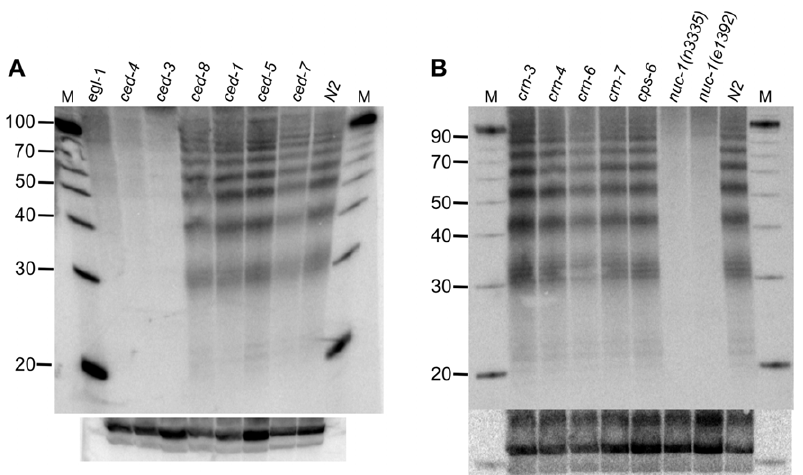
Figure 2. Analysis of small DNA pieces in C.elegans apoptosis mutant strains. Northern analyses as in Figure 1 were performed on ‘‘total RNA’’ isolated from C. elegans embryos of wildtype (N2) animals or those containing mutations in genes that affect the killing or engulfment phase of apoptosis (A) or those implicated in nucleolytic degradation of DNA during apoptosis (B). For each strain, multiple northern analyses (2–5) were performed on multiple, independent RNA preparations (2–5) and representative data are shown. As much as possible, cultures of various strains were maintained at similar developmental stages, but embryos isolated from gravid adults varied slightly in their precise stage. This may explain the variation in levels of small DNA pieces between strains; further, some differences may be due to mutations in apoptosis genes that alter the kinetics of PCD. The blot shows an absence of small DNA pieces in ced-3(n717) , and other alleles ( n1286, n2888) gave identical results (Figure S4). Blots were reprobed for U6 as a loading control (bottom panels).